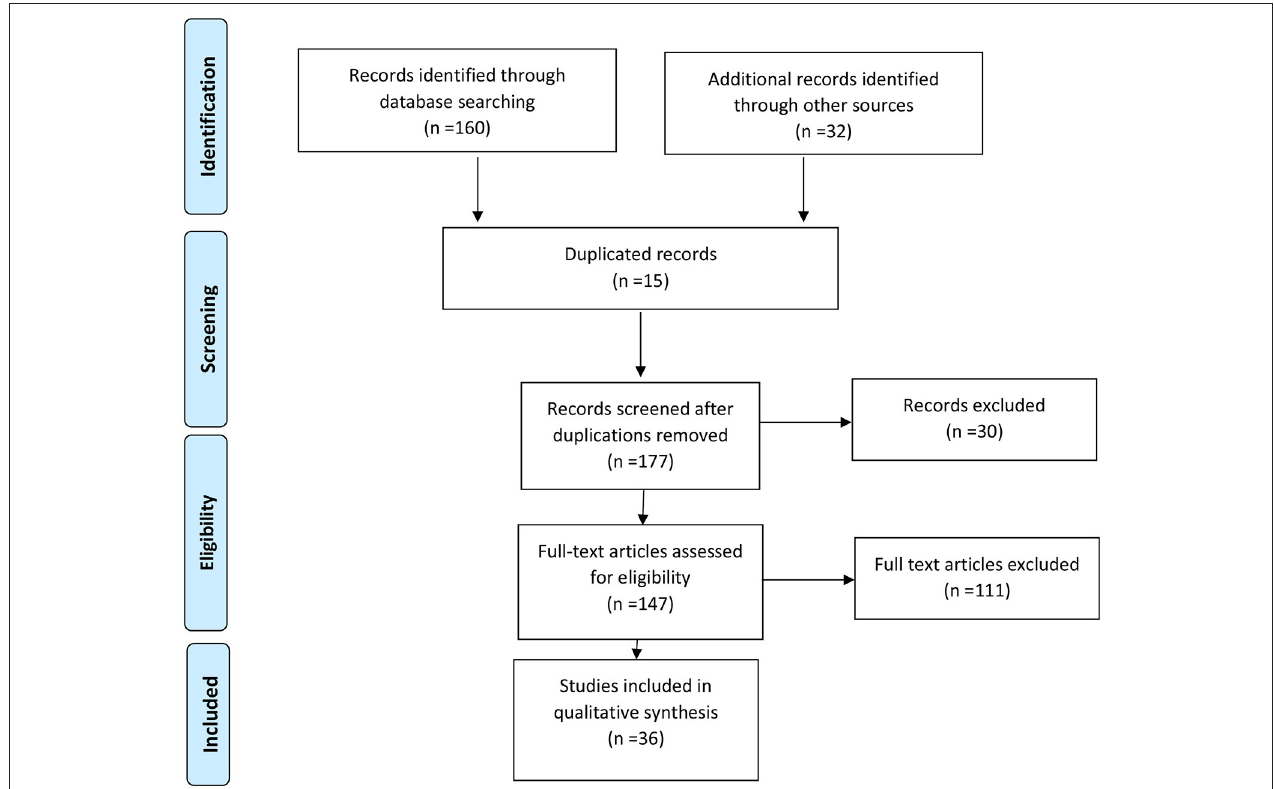
FIGURE 1 | PRISMA